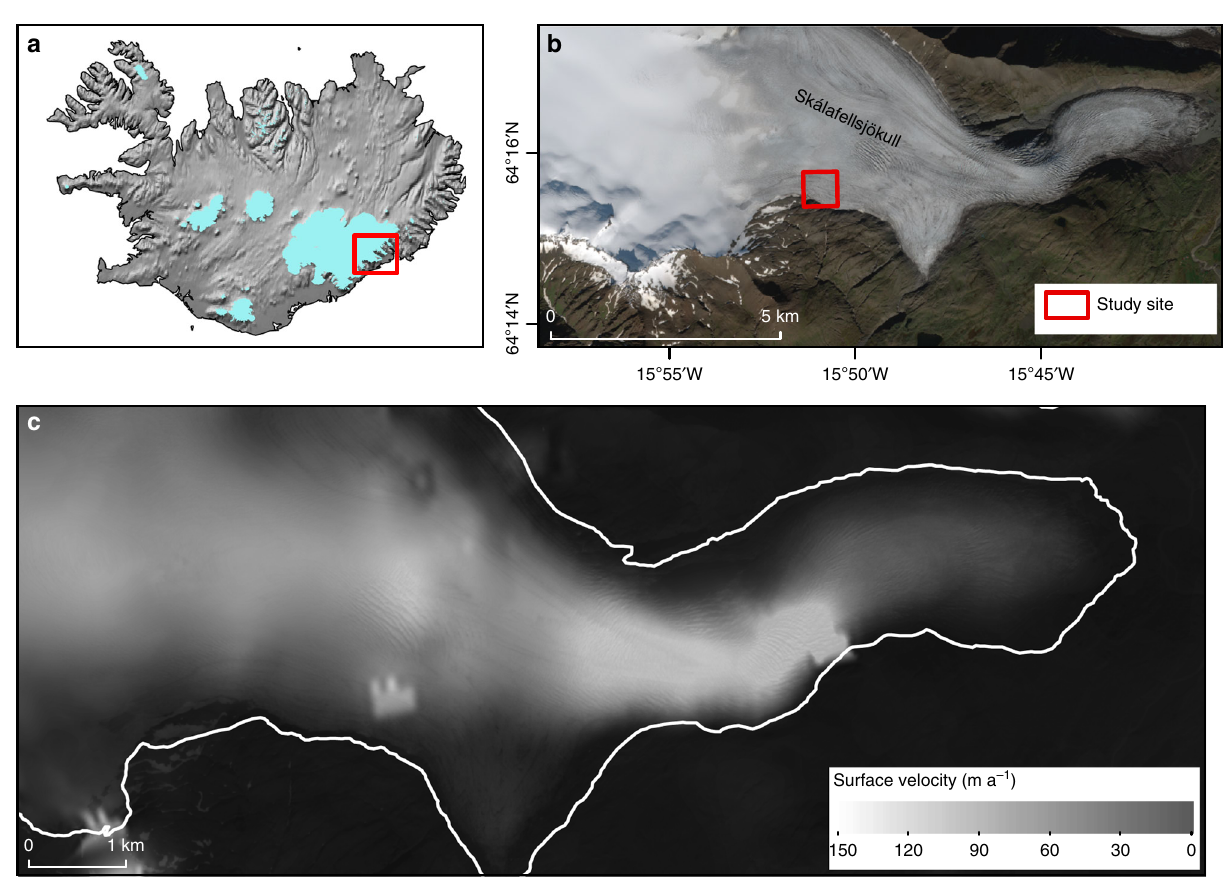
Fig. 1 Site map of Skálafellsjökull: a location in Iceland (shown by a box) (background: hillshade model based on the national DEM of Iceland); b details of the glacier (background: Sentinel 2 natural colour composite from 30 August 2017); c glacier wide surface ice velocity estimated from intensity tracking of two Single Look Complex (SLC) TerraSAR-X images with an eleven-day temporal baseline (5th and 16th October 2012) (glacier outline shown in